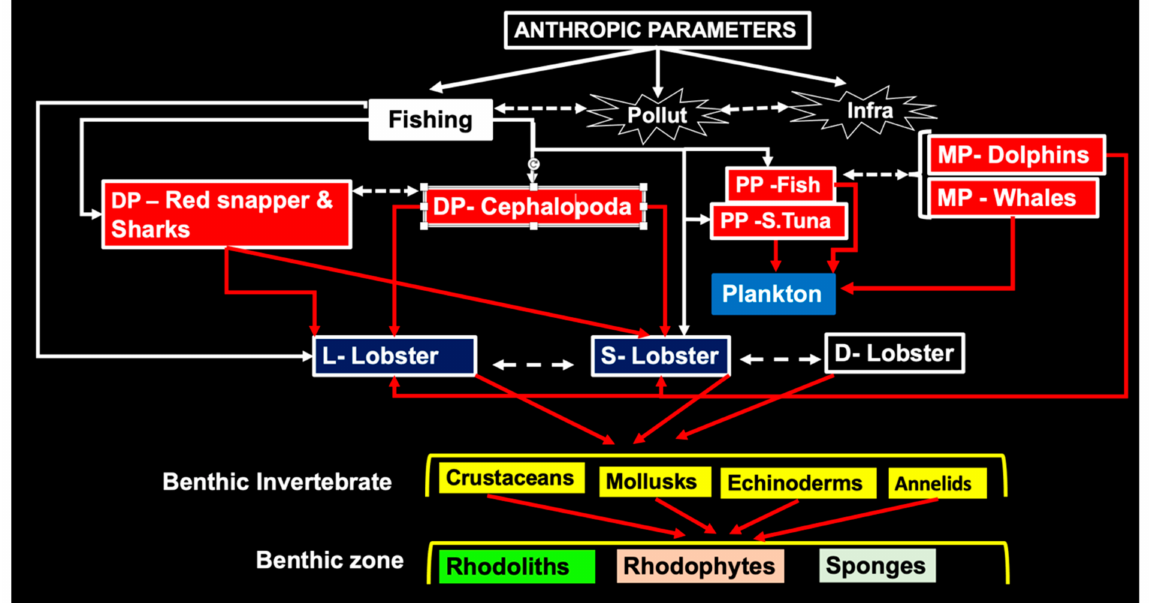
Figure 12. Theoretical scheme showing ecosystem and trophic interactions between lobsters, potential predators (box and line in red) and fisheries. DP = demersal predators. P = predators. PP = pelagic predators (S. tuna = small tuna). MP = mammal predators (dolphins and whales). L = spiny lobster; S = slipper lobster. D = deep-sea lobster (without information on its ecology). Plankton = phyllosomata. Benthic invertebrates = main lobster diet (benthic and infaunal organisms). Benthic zone = ecological region at lowest level of a body of water. Rhodoliths = composed of several species of calcareous algae. Rhodophytes = red algae. Sponges = increases availability of shelters for different species and juveniles. Pollut = pollution. Infra = infrastructure developments. Dotted arrows = probable